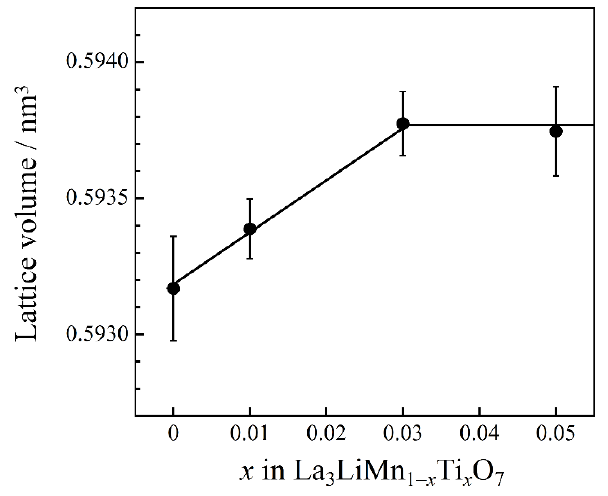
Figure 2. Compositional dependence of the lattice volume for La 3 LiMn 1 − x Ti x O 7 (0 ≤ x ≤ 0.05).